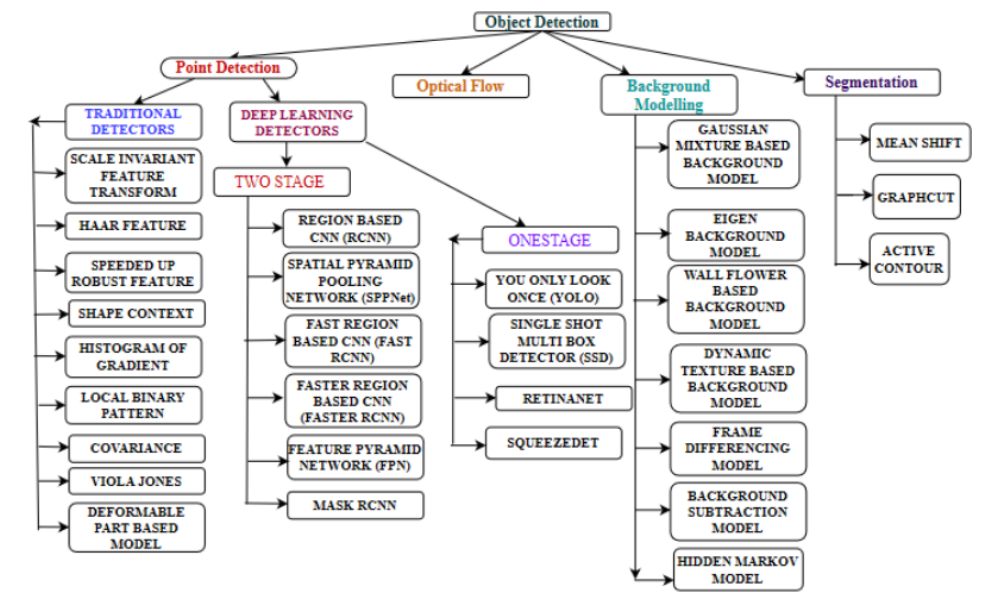
Figure 3. Various approaches in object